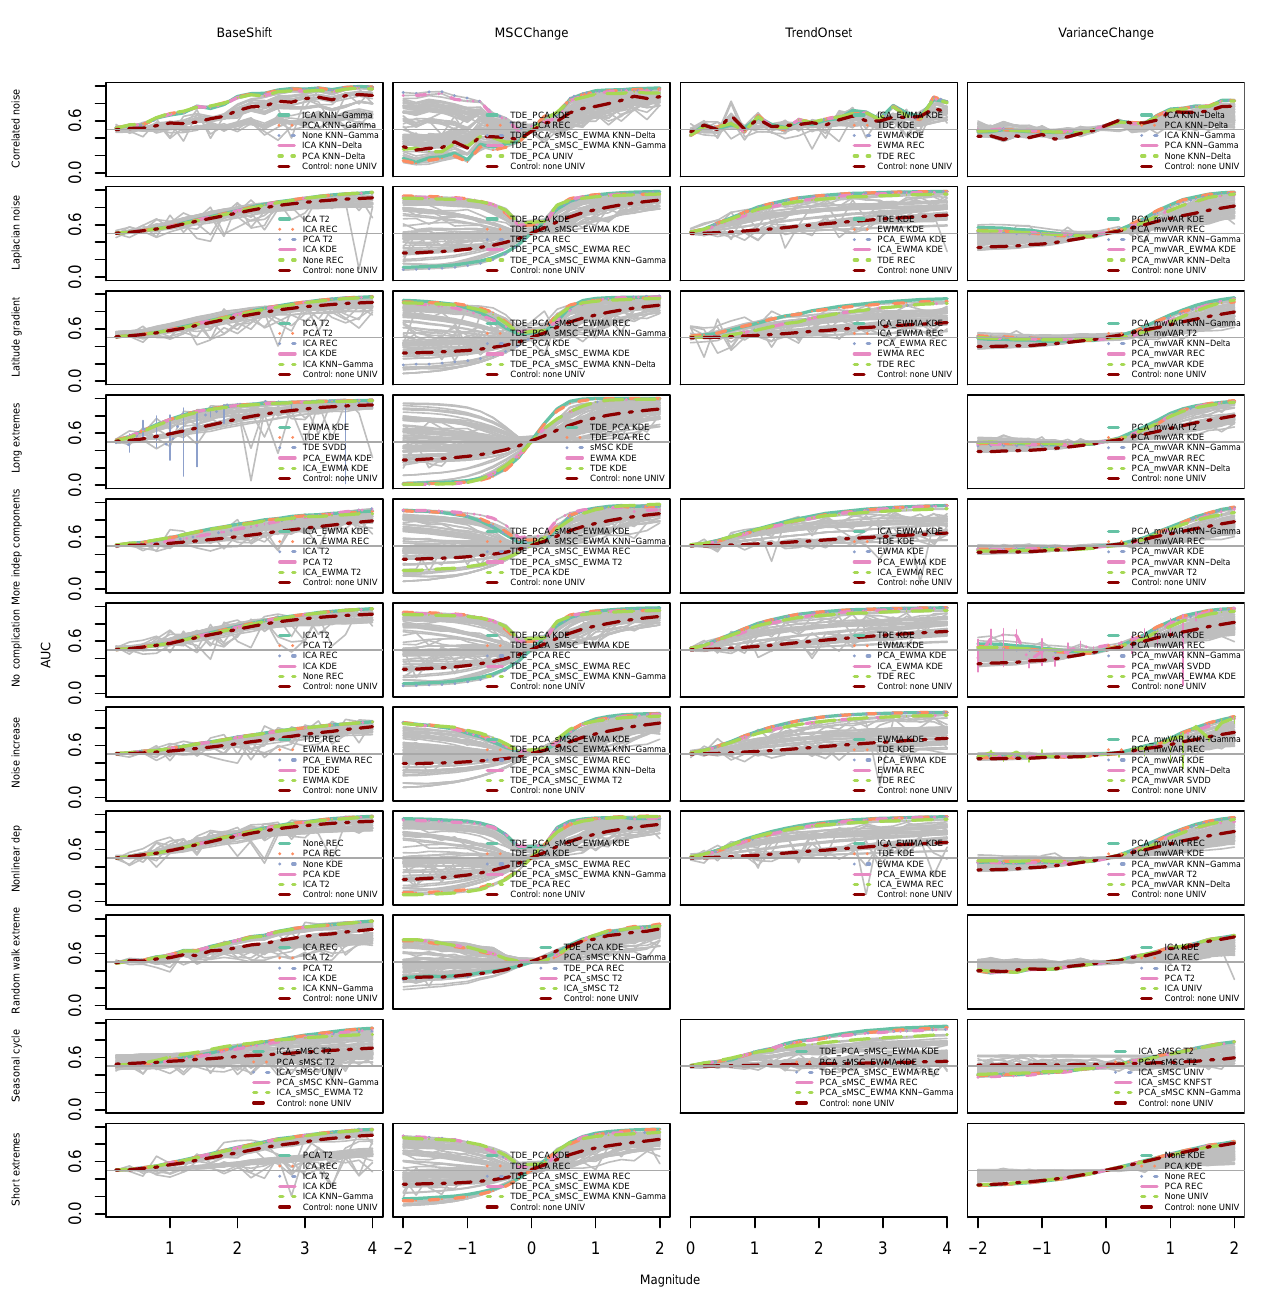
Figure B1. AUC versus event magnitude for all combinations (grey) and the univariate control (red). Columns of the matrix represent different event types; rows represent data properties. Additional colored workflows represent the workflows with the five highest mean values for the magnitudes > 2SD ( > 0 .